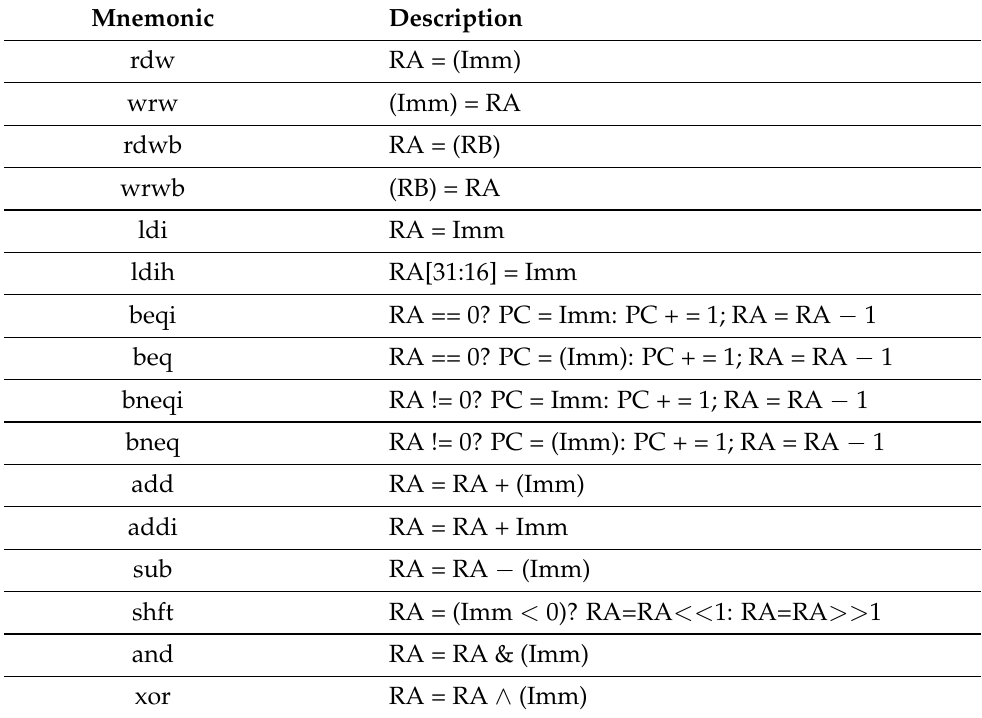
Table 3. Instruction